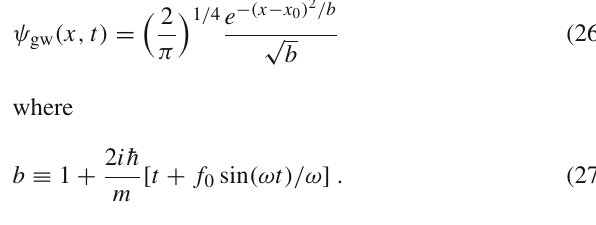
Fig. 1 The difference in the mass Fisher information in a GW back- ground from the free case, over time. As the difference can be non-zero, one can extract mass information of the particle from the GW, in viola- tion of the